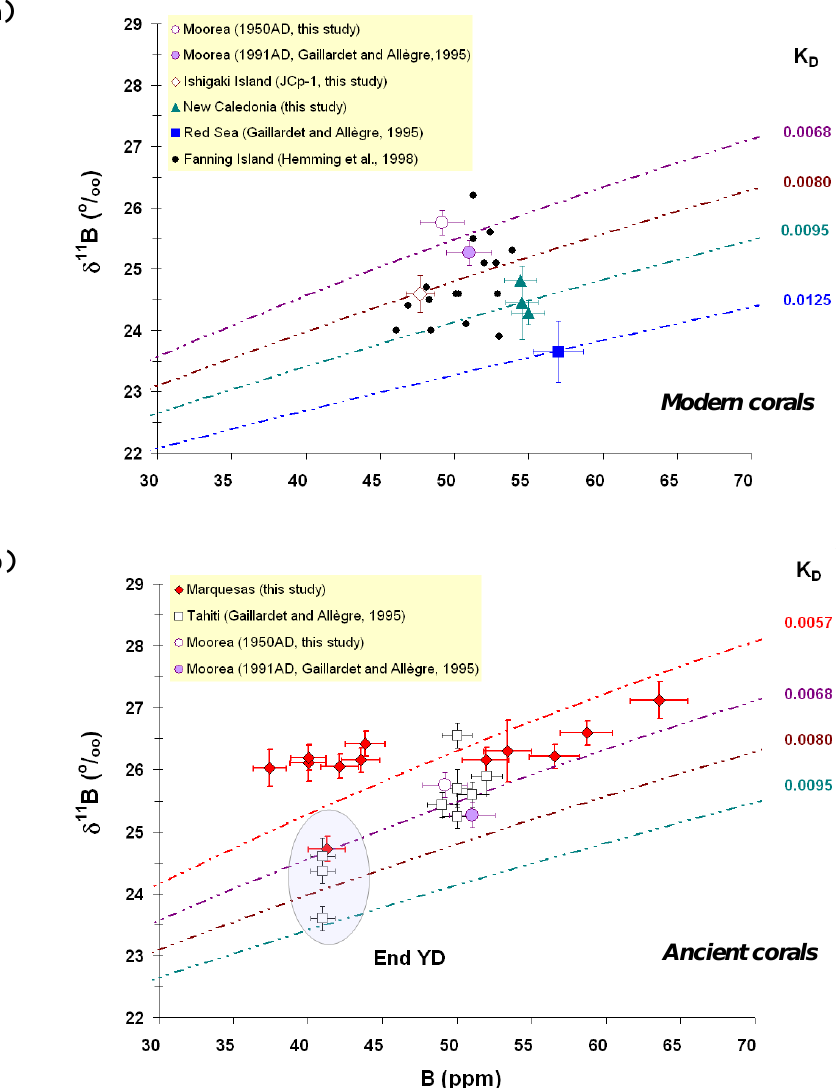
Fig. 4. The δ 11 B values plotted against the boron concentrations (a) for modern Porites from various geographical areas and (b) for ancient Porites and Acropora near Marquesas and the Tahiti Islands. The theoretical curves for different partition coefficient K D values were calculated assuming T =28 ◦ C; S =35‰; α =0.981; and δ 11 B SW =39.9‰. Seawater values used were [B] seawater =416µM and T CO 2